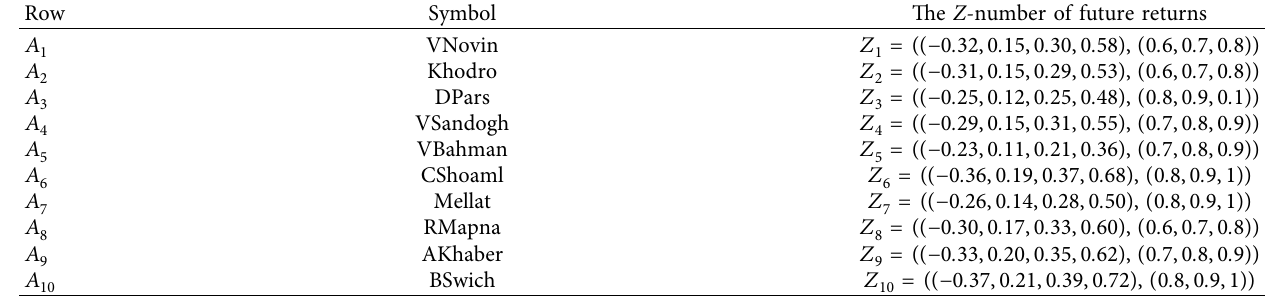
Table 3: Information about assets and their returns.